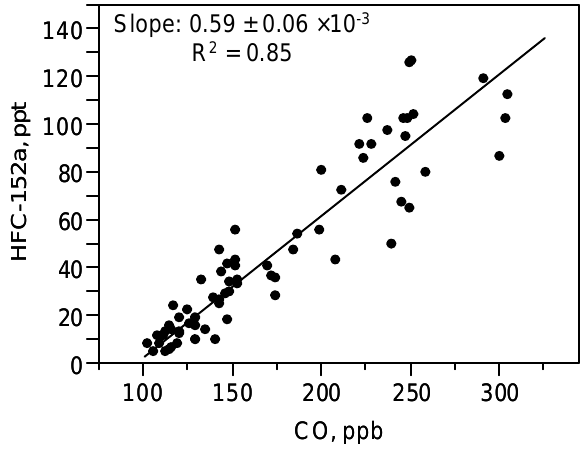
Fig. 7. Mixing ratios of HFC-152a versus CO for the samples col- lected over the LA area.